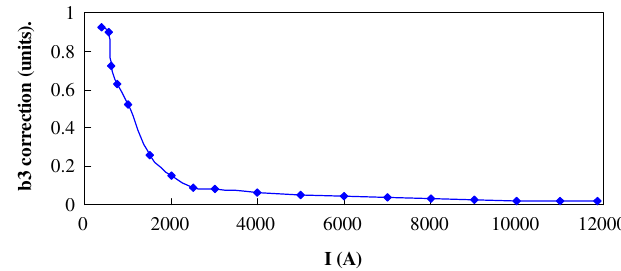
FIG. 11. (Color) The b 3 correction to be implemented on the loadline ramp-up measurements of the LHC dipole magnet population. The values from the plot above are subtracted from the loadline